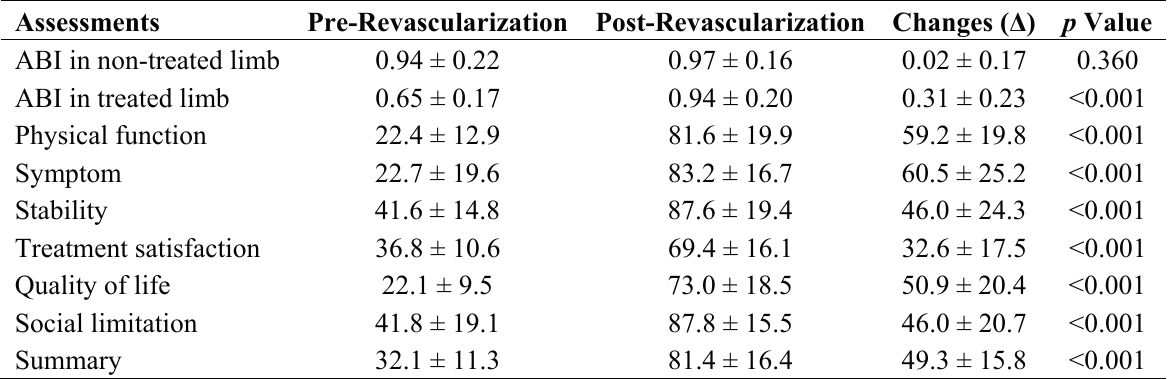
Table 2. PAQ scores and ABI prior to and three months after